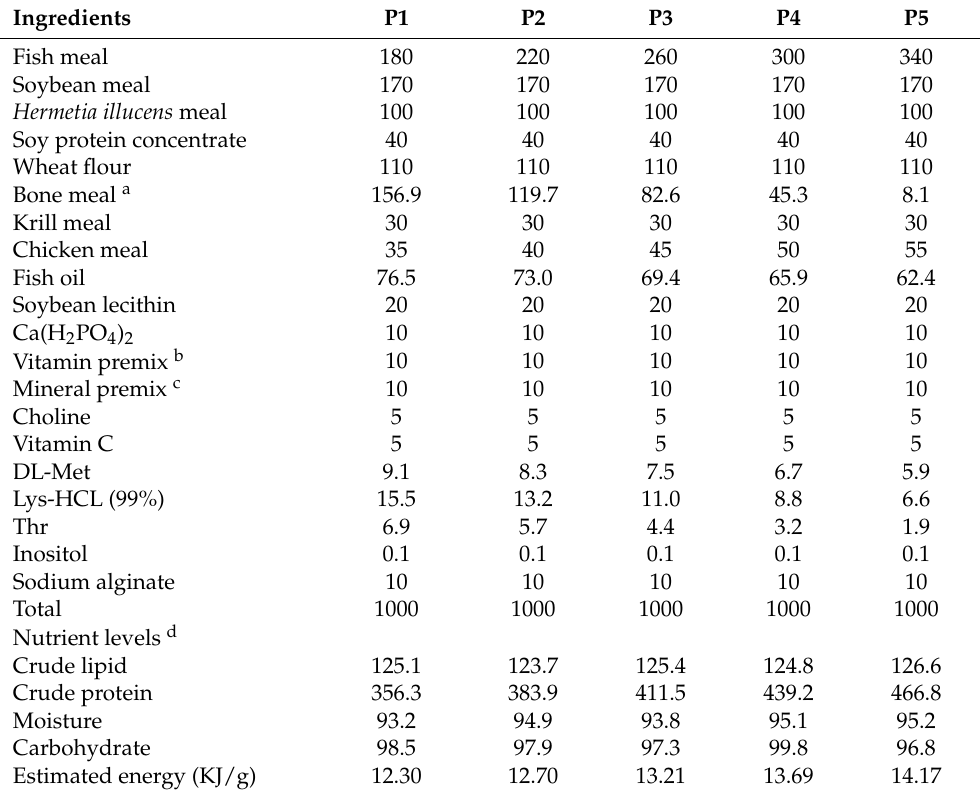
Table 1. Composition and nutrient levels of the experimental diets (g/kg dry